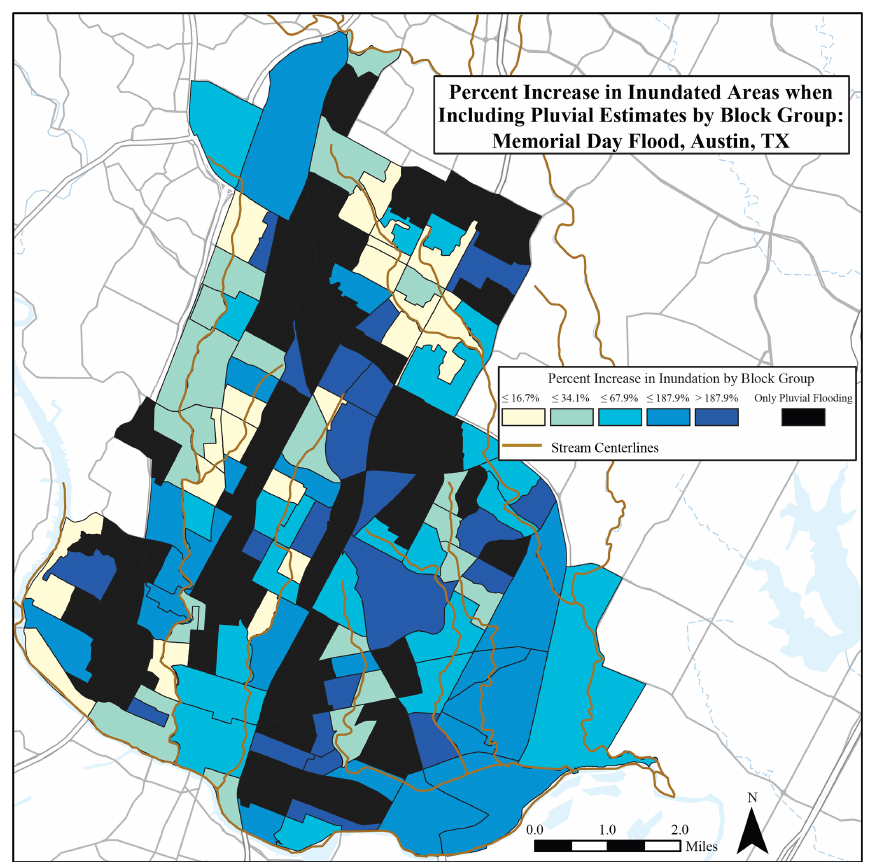
Figure 5. Percent increase in inundation extent by census block group when comparing fluvial/pluvial flooding with only fluvial sources during the 2015 Memorial Day flood in Austin, Texas. Darker colors signify a greater percent increase, with black block groups only experiencing pluvial sources. Table 4. Percent increase in inundation extent by catchment area when comparing fluvial/pluvial flooding with only fluvial sources during the 2015 Memorial Day flood in Austin,